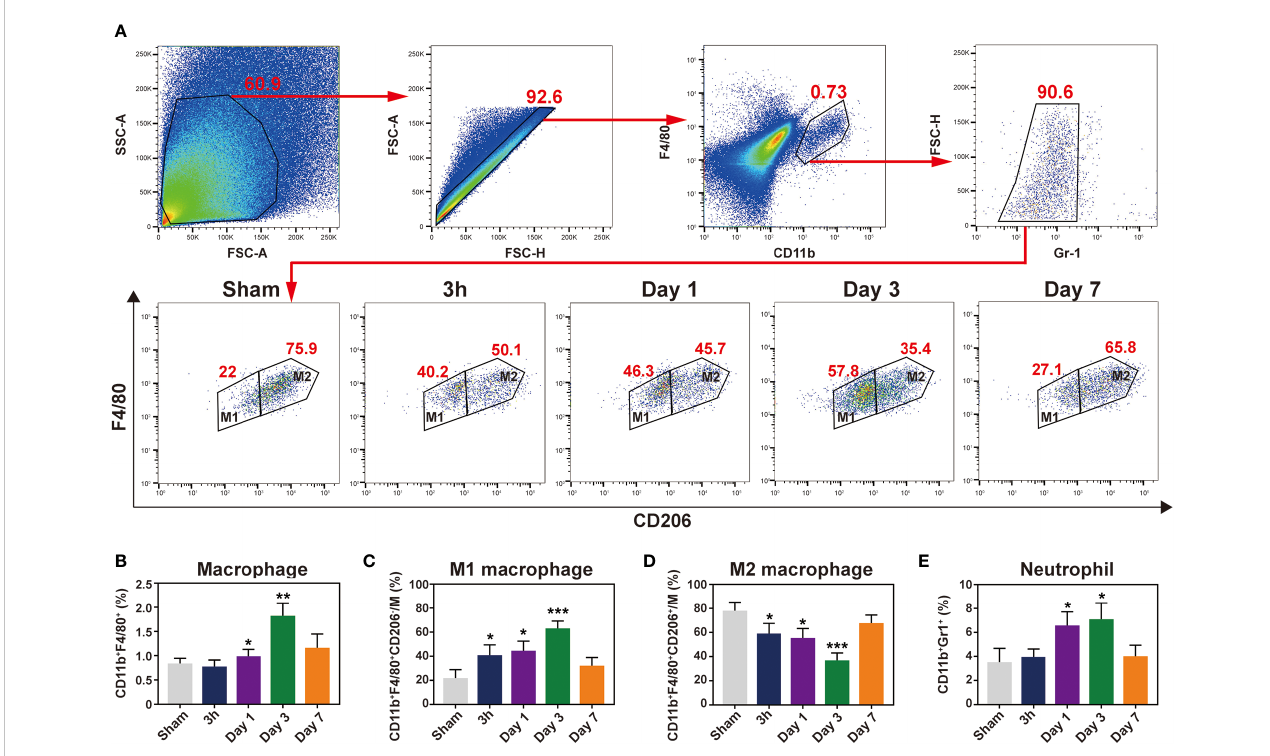
FIGURE 4 Characterization of temporal dynamic of the macrophages and neutrophil in the heart after IR. (A) , gating strategy for cardiac macrophages, M1 (CD11b + F4/80 + Gr1 - CD206 - ) and M2 (CD11b + F4/80 + Gr1 - CD206 + ) macrophages at indicated time point after myocardial IR injury. Represent fl ow cytometric images of M1 and M2 macrophages in the post-IR heart. (B-E) , the percentages of macrophages (B) , M1 (C) , M2 (D) and neutrophils (E) were determined in the hearts of sham group and reperfusion groups (n = 5-6, each). *p < 0.05 VS. Sham, ** p < 0.01, *** p <